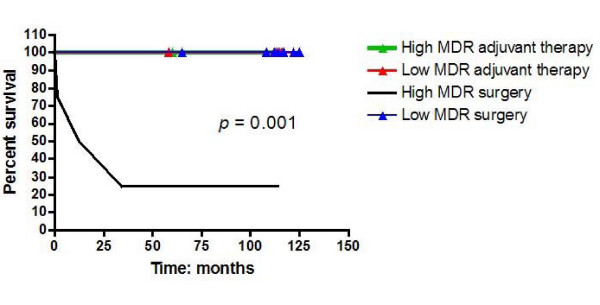
Stage adjusted disease specific survival rate according to MDR-1 expression and therapy in patient affected by RCC in early stage (stage I). The group of patients with high MDR-1 expression without adjuvant therapy showed poor survival (p < 0.05). This finding outlines a) the role of occult metastases at the time of diagnosis and b) confirms a possible role of MDR-1 as prognostic factor independent of multidrug resistance.